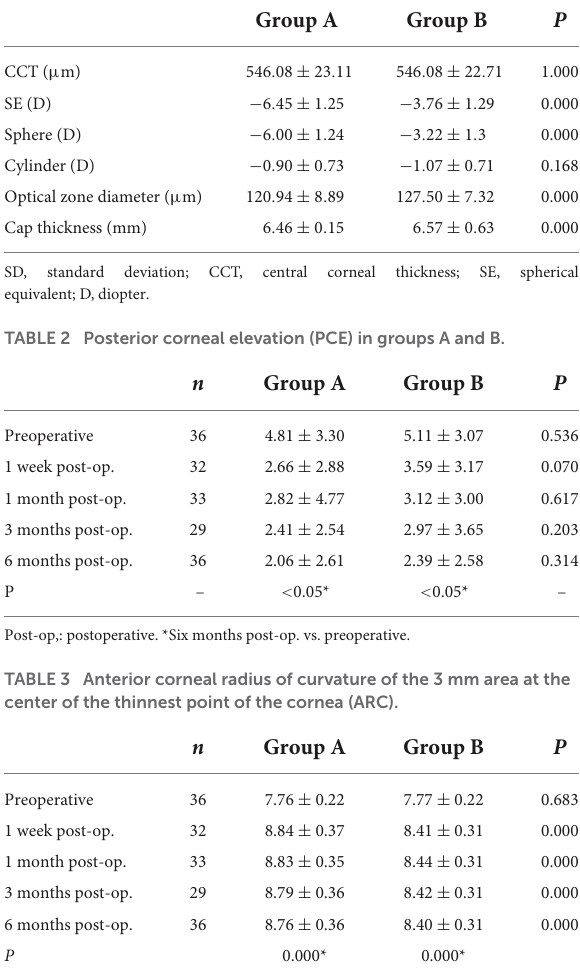
TABLE 1 Preoperative refractive and corneal data (mean ± SD).